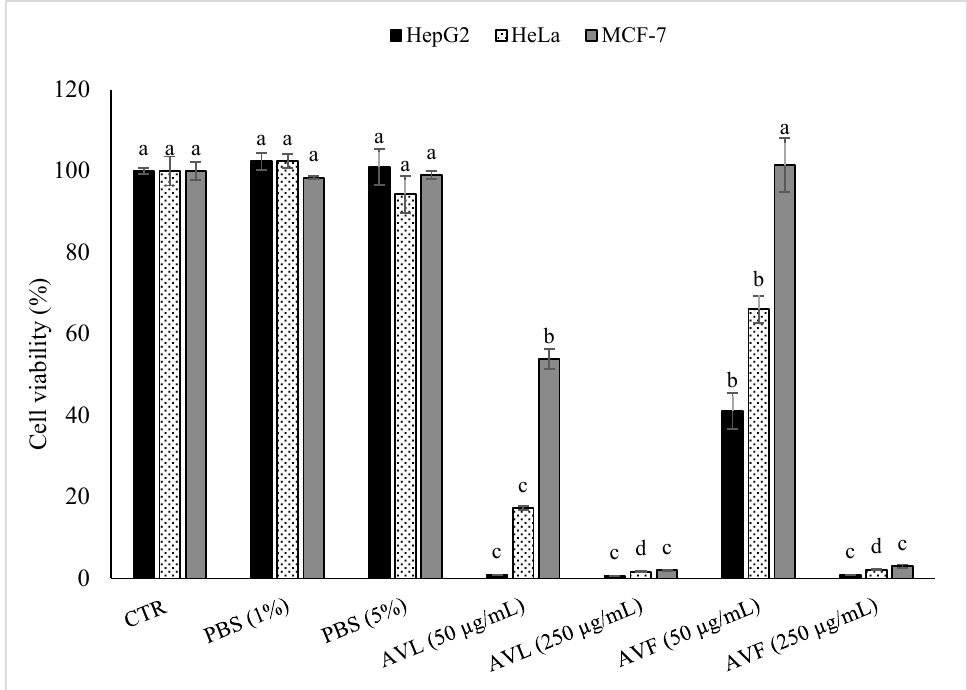
Figure 3. Effect of A. vulneraria leaf (AVL; 50 µg/mL and 250 µg/mL) and flower (AVF; 50 µg/mL and 250 µg/mL) extracts on cell viability assayed 48 h after treatment. CTR, non-treated cells; PBS, control cells incubated in the presence of solvent without A. vulneraria extracts. AVL and AVF extracts were dissolved in PBS and extracted PBS solutions were added at 1% or 5% in cell medium, which corresponded to a final concentration of 50 µg/mL and 250 µg/mL of extract, respectively. Error bars represent the standard deviation ( n = 3). Lowercase letters indicate significant differences between treatments (CTR, PBS 1%, PBS 5%, AVL 50 µg/mL, AVL 250 µg/mL, AVF 50 µg/mL, AVF 250 µg/mL) for each cell line assayed (with α = 0.05).